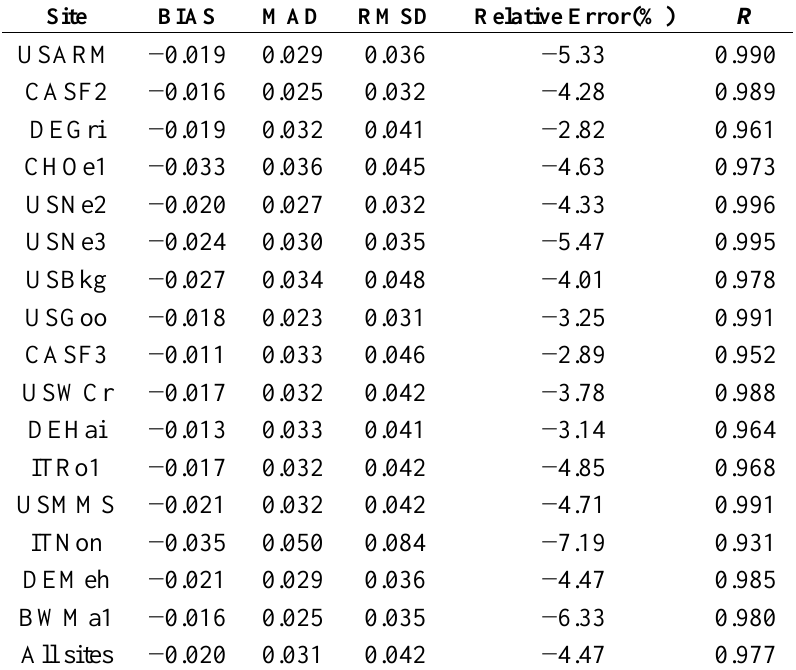
Table 2. Statistical results for the comparisons between instantaneous EF at MODIS overpass time and daytime average EF